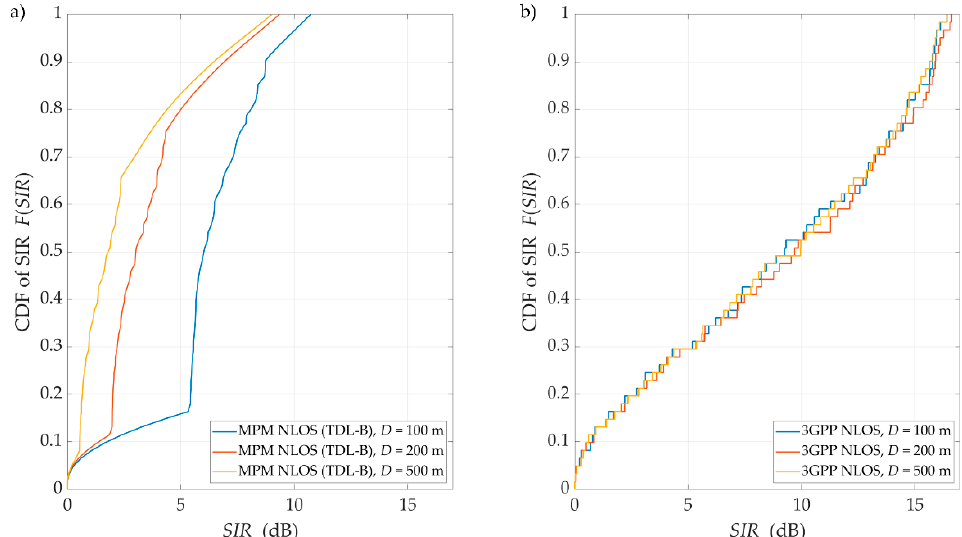
Figure 10. CDFs of SIR for NLOS conditions and selected distances obtained for ( a ) the MPM and ( b ) the 3GPP model.